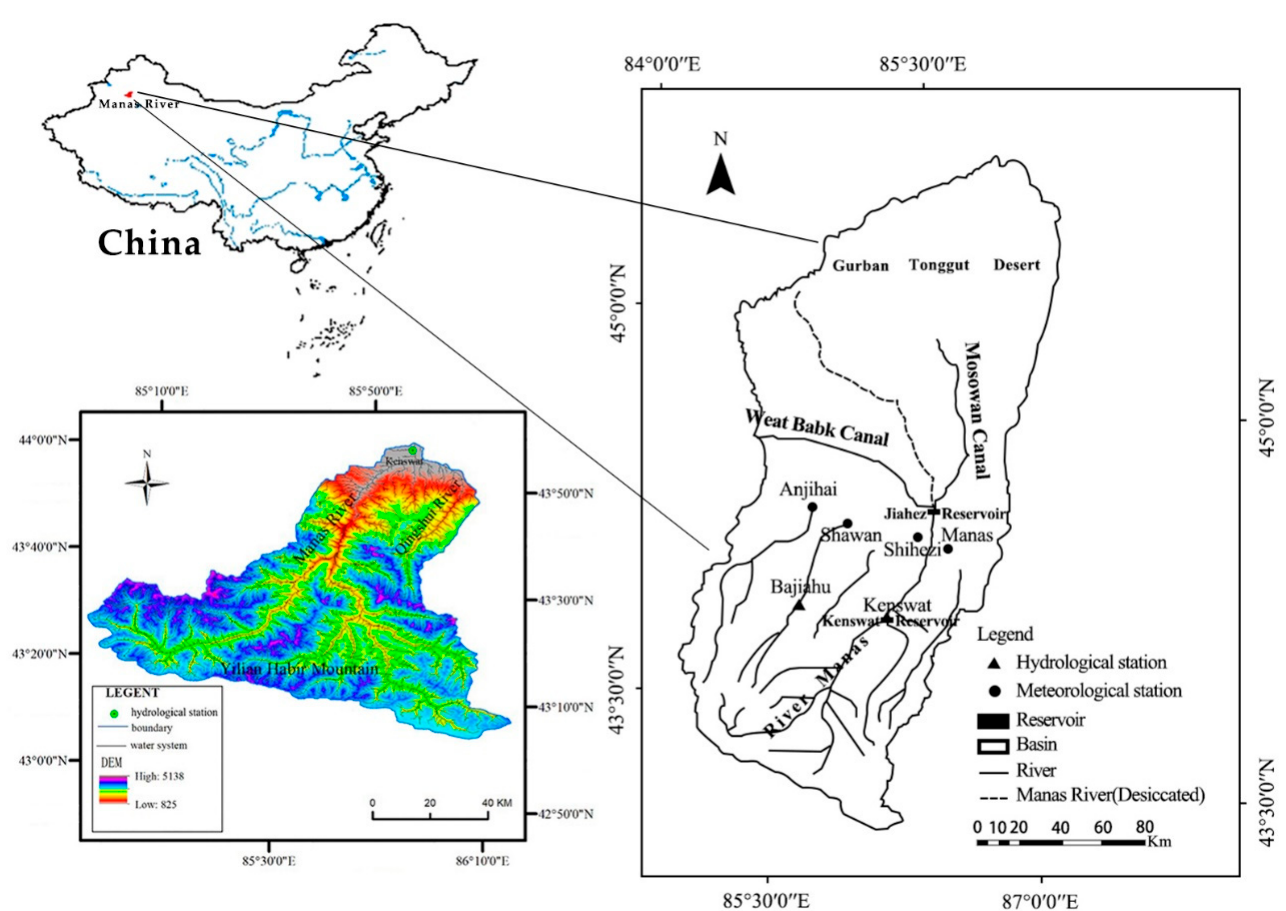
Figure 1. Location of the Manas River Basin and its upstream DEM map.